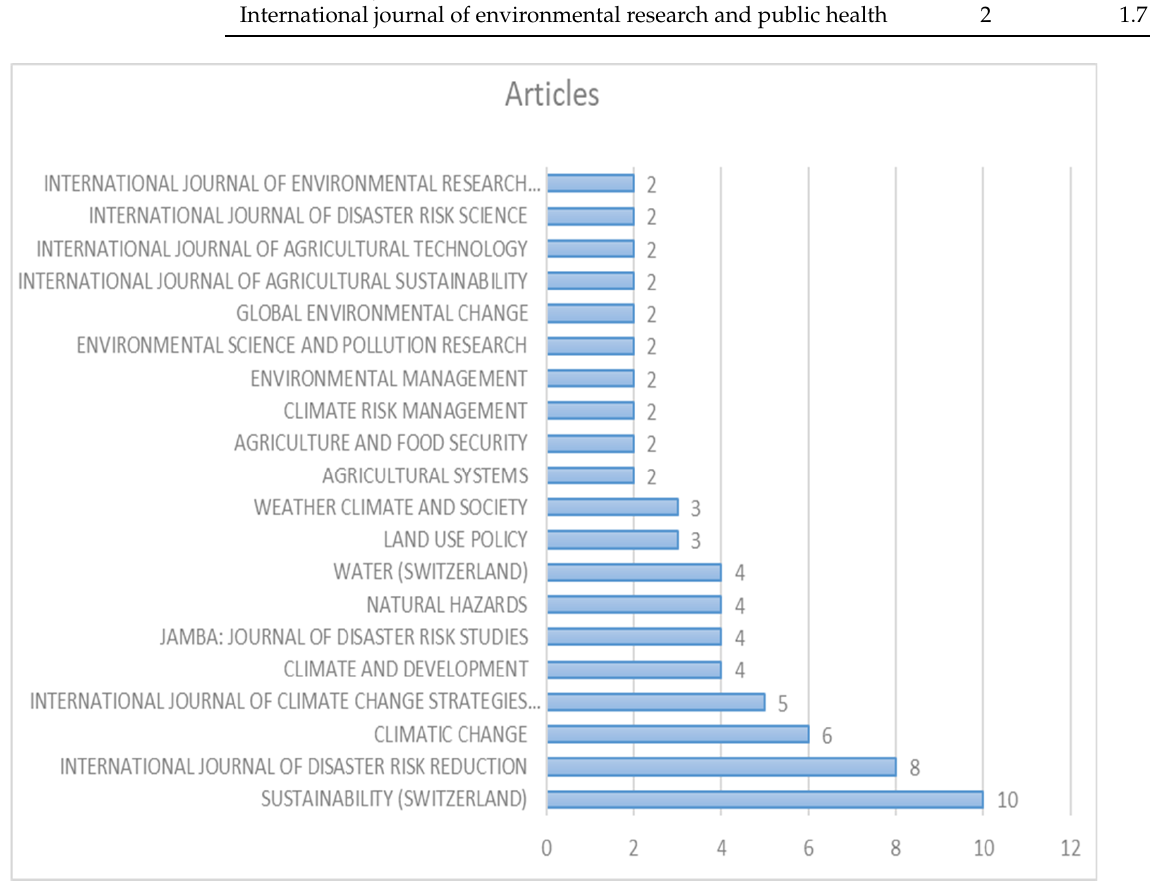
Figure 4. Top 20 most relevant sources .